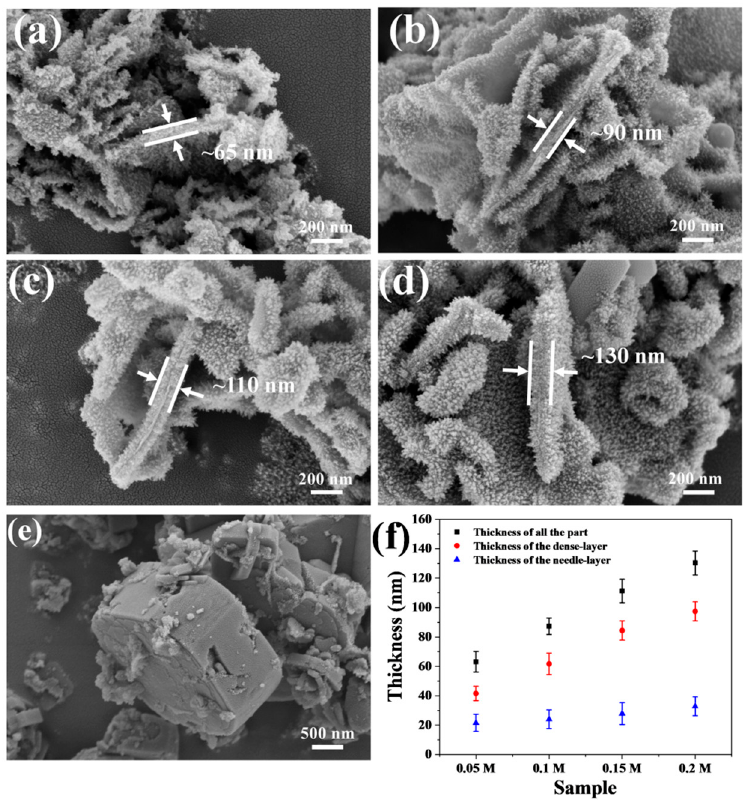
Figure 4. SEM images of the samples prepared with different (NH 4 ) 2 TiF 6 concentrations before cal- cination: ( a ) 0.05 M, ( b ) 0.1 M, ( c ) 0.15 M, ( d ) 0.2 M, ( e ) 0.3 M. ( f ) The thickness data of the samples.